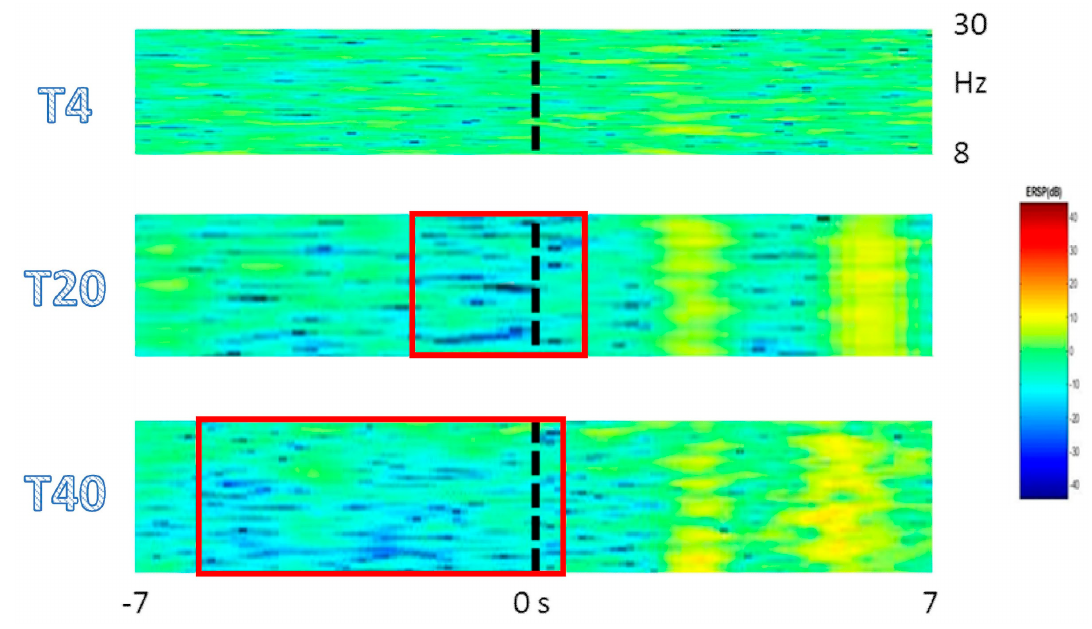
Figure 4. The extraction of event-related spectral perturbation (ERSP) maps from C3, which showed desynchronization between 8 and 30 Hz at T20 and T40 as compared to the baseline (T4). Significant time periods (all p = 0.01) are marked in red.